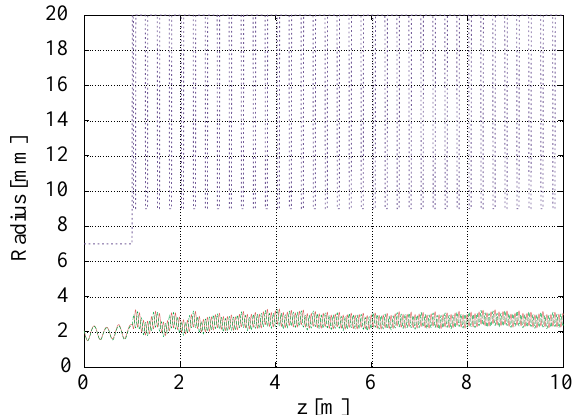
FIG. 10. (Color) Evolution of transverse rms envelopes (hori- zontal: solid red line; vertical: dashed green line). Beam pipe wall and rf cavities are superimposed (dotted blue